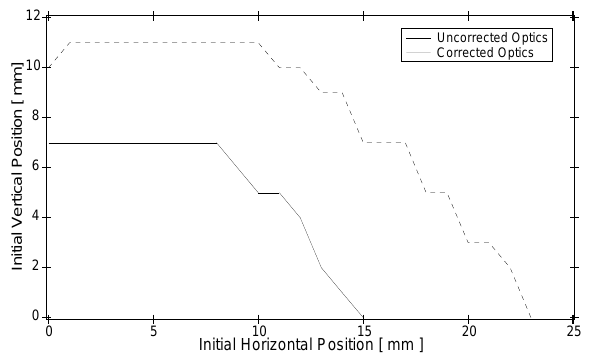
FIG. 9. A comparison of the calculated dynamic aperture before and after the optic is